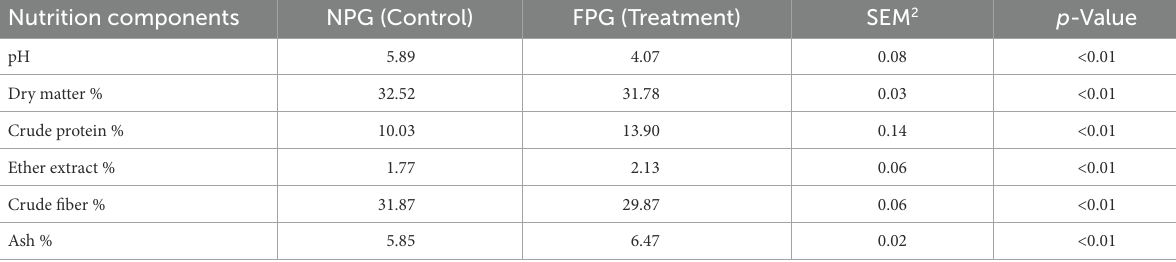
TABLE 1 Analysis of the nutritional components of the roughage in the experimental period 1 . Nutrition